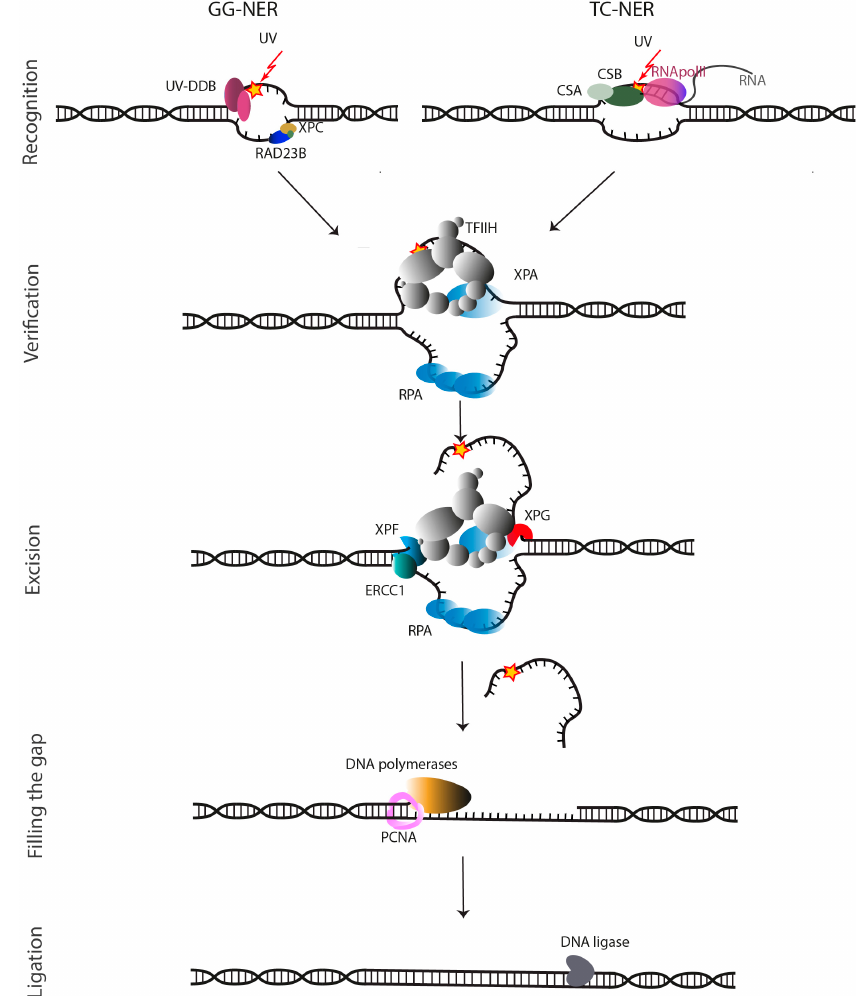
Figure 1. Schematic overview of the Nucleotide Excision Repair (NER) pathway. Lesion recognition leads to GG-NER, whereas stalled transcription leads to TC-NER. This is followed by damage verification, incision at 5 ′ side by ERCC1-XPF and 3 ′ side of the lesion by XPG. The gap left after the incisions is refilled by DNA re-synthesis. Adapted from [22,24,28] .